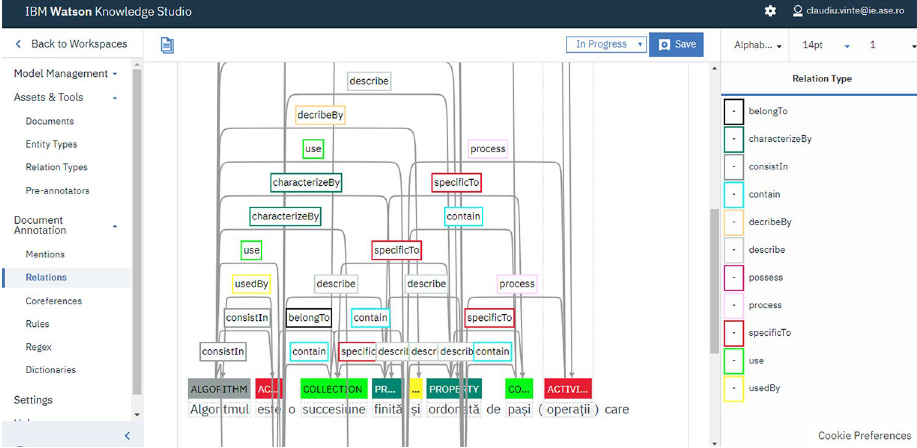
Figure 3. The manual annotation of relation types on a training